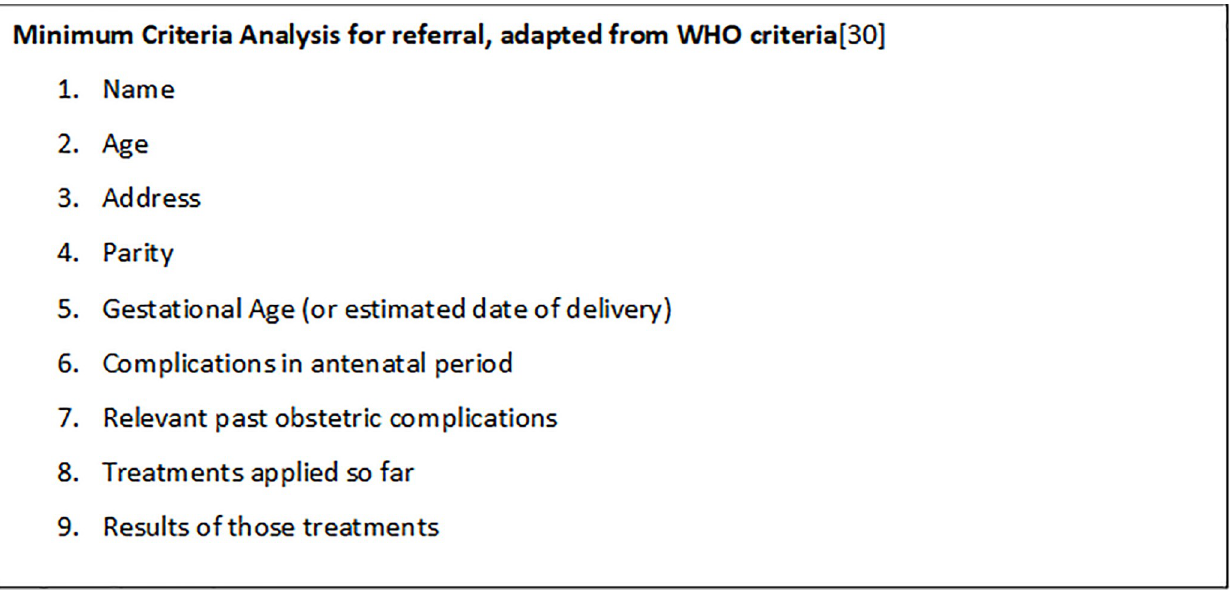
Fig 3. Minimum criteria. Minimum criteria for referral pattern improvement were adapted from WHO criteria[30] after consultation with maternal health experts at the UK Royal College of Obstetrics and Gynaecology. Criteria are applied to all admissions on the inference that the transfer of care from antenatal services to maternity unit admission is a form of